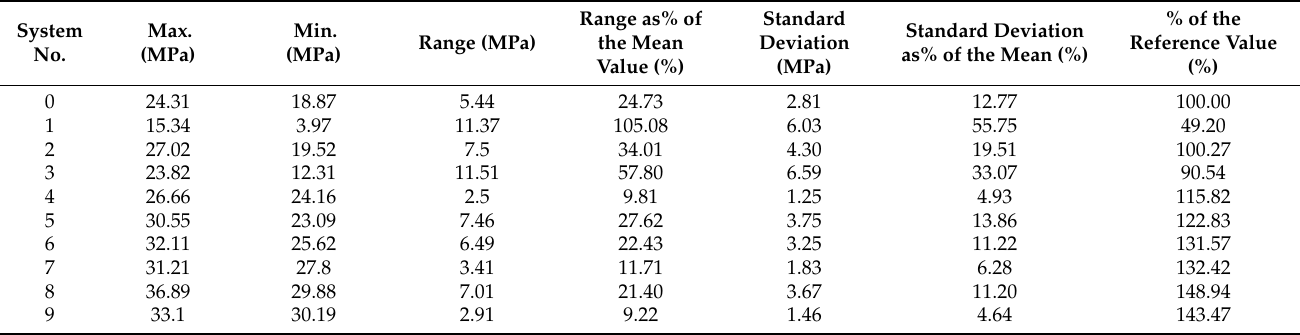
Figure 6. Compressive strength change in relation to the type and amount of nanosilica additive. Table 3. Selected statistical parameters of the obtained results.